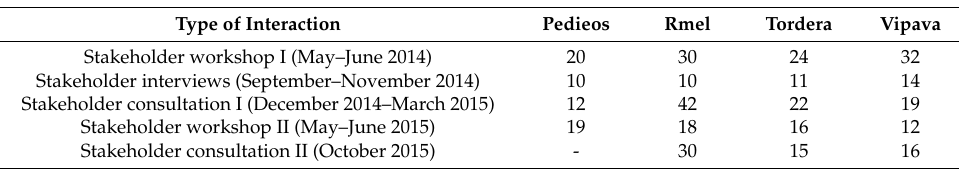
Table 3. Type of stakeholder interactions and number of stakeholders involved in the Pedieos, Rmel, Tordera and Vipava river